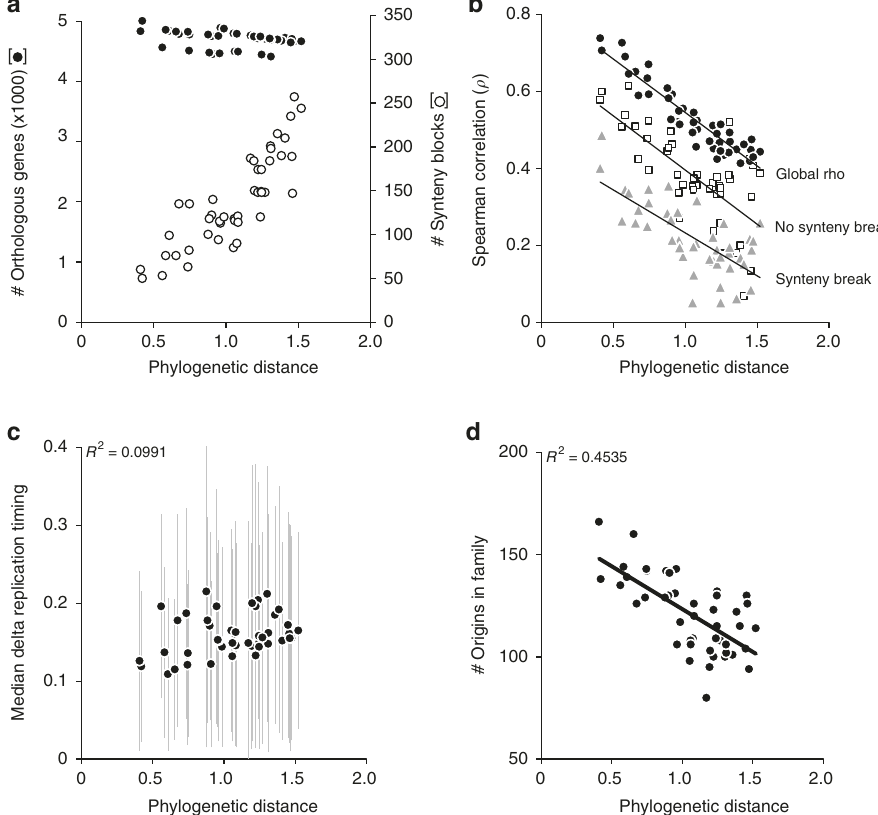
Fig. 2 Evolution of genomic properties in the genus Lachancea . In all panels, each point corresponds to a pairwise comparison between two Lachancea species. The values of the property indicated on the y -axis are plotted as a function of the phylogenetic divergence between all pairs of Lachancea species as de fi ned in ref. 31 . a The number of syntenic homologs and synteny blocks are represented by black and open circles, respectively. b Comparison of global and local correlation coef fi cients between pairs of genome replication timing pro fi les. The global coef fi cient plot (black circles) is identical to that of the blue dots in Fig. 1c ( R 2 = 0.868, P < 2.2×10 − 16 ). Open squares and gray triangles represent the local correlation coef fi cients averaged over the same number of regions of fi ve genes that are either located 25 genes away from the synteny breakpoints ( R 2 = 0.502, P = 2.24×10 − 6 ) or directly fl ank the breakpoints ( R 2 = 0.477, P = 1.6×10 − 6 ), respectively. c Origin fi ring time differences between conserved replication origins in all pairs of species. The y - axis corresponds to the normalized replication timing difference between orthologous origins. For each species, the average replication timing data (presented in Supplementary Fig. 1) were normalized between 0 and 1. The distributions of differences in normalized activation timing between orthologous origins are shown for all pairwise comparisons. The black dots indicate the median values for pairwise comparisons and the gray bars show the standard deviations. d Relative conservation of active replication origins in the different pairs of Lachancea genomes ( R 2 = 0.45, P = 3.9×10 − 07 ). The y- axis corresponds to the number of active origins found to be conserved between each pair of